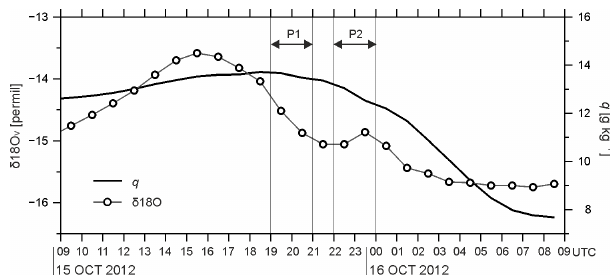
Figure 6. Domain-averaged δ 18 O v (line with dot) and q (thick line) in the domain of southern Italy (SI) at the first model level (approx- imately 20m height) (limited to the grid point where the topogra- phy is lower than 20m), from 09:00UTC on 15 October 2012 to 09:00UTC on 16 October 2012. The location of the domain SI is depicted by the box in Figs. 1, 3, and